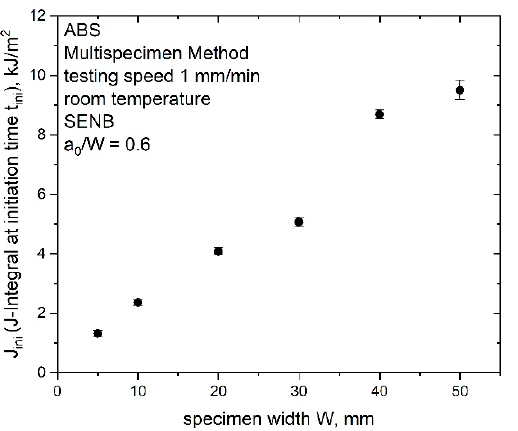
Figure 14. Growing initiation toughness value J ini (J-integral at the initiation time t ini ) for increasing specimen sizes (W is 5, 10, 20, 30, 40 and 50 mm) of ABS.